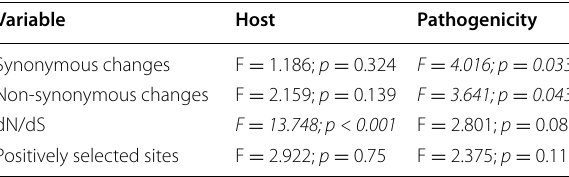
Table 3 ANOVA results: effects of Host species and patho- genicity on genetic parameters